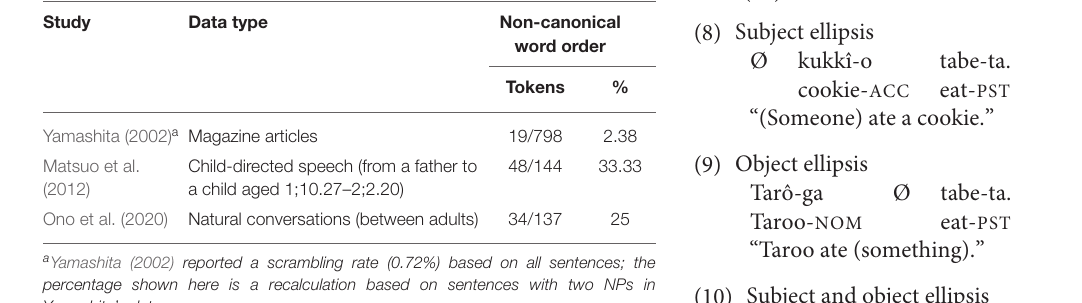
TABLE 1 | Previous findings on the frequency of non-canonical word-order sentences in Japanese: raw tokens and proportions (%) of all two-NP sentences in the